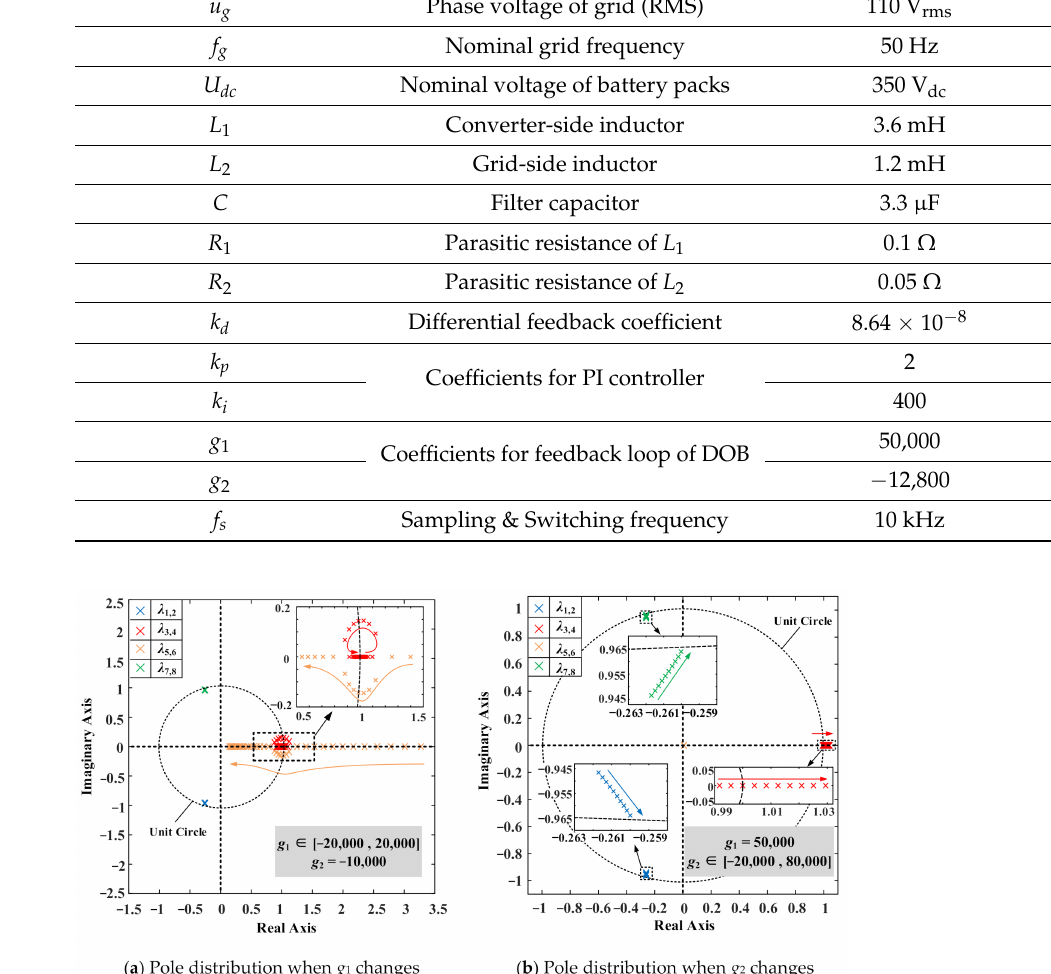
Figure 7. Pole distribution of G − M d C 0 when g 1 and g 2 are